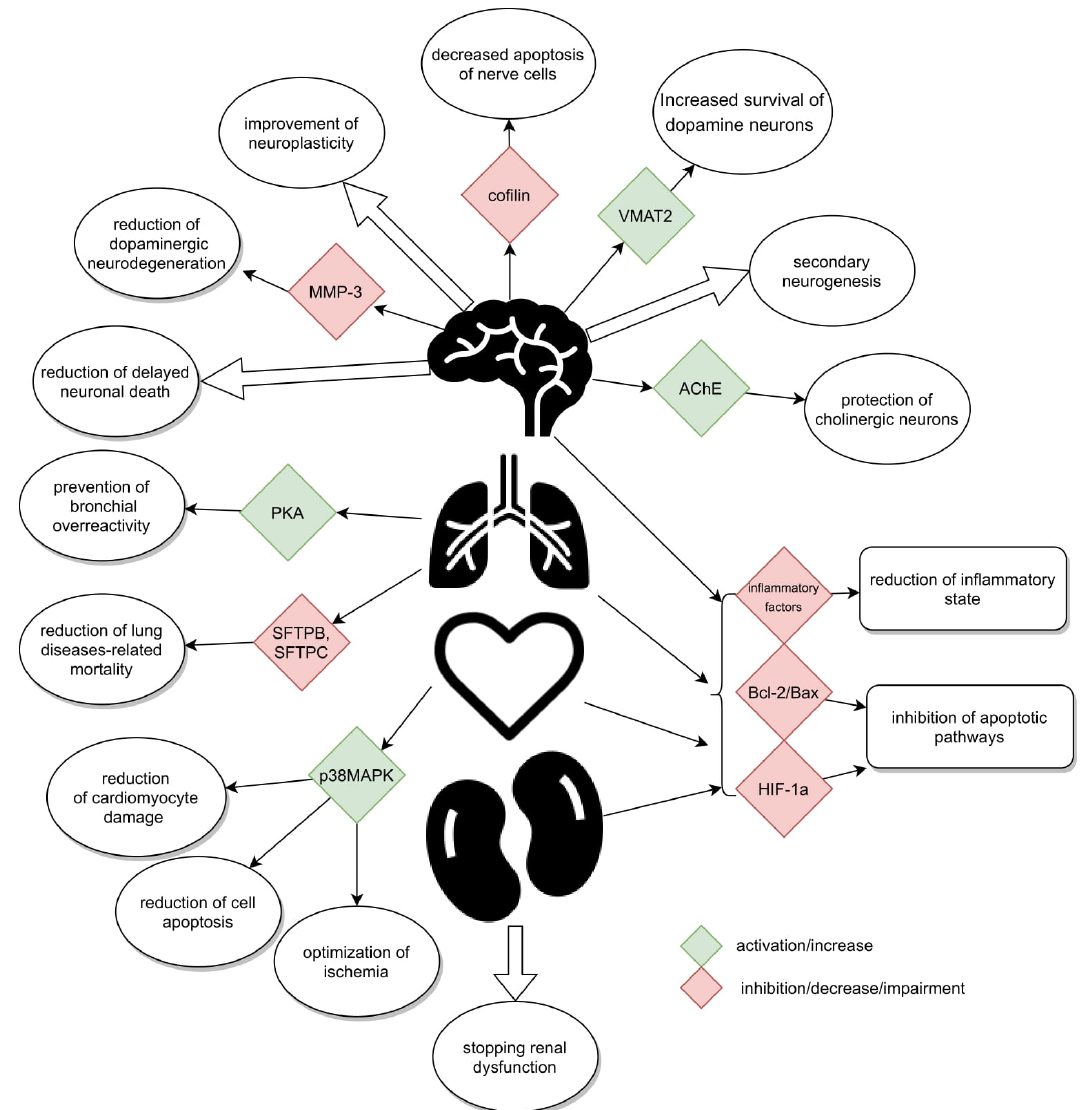
Figure 1. Schematically presented mechanisms.